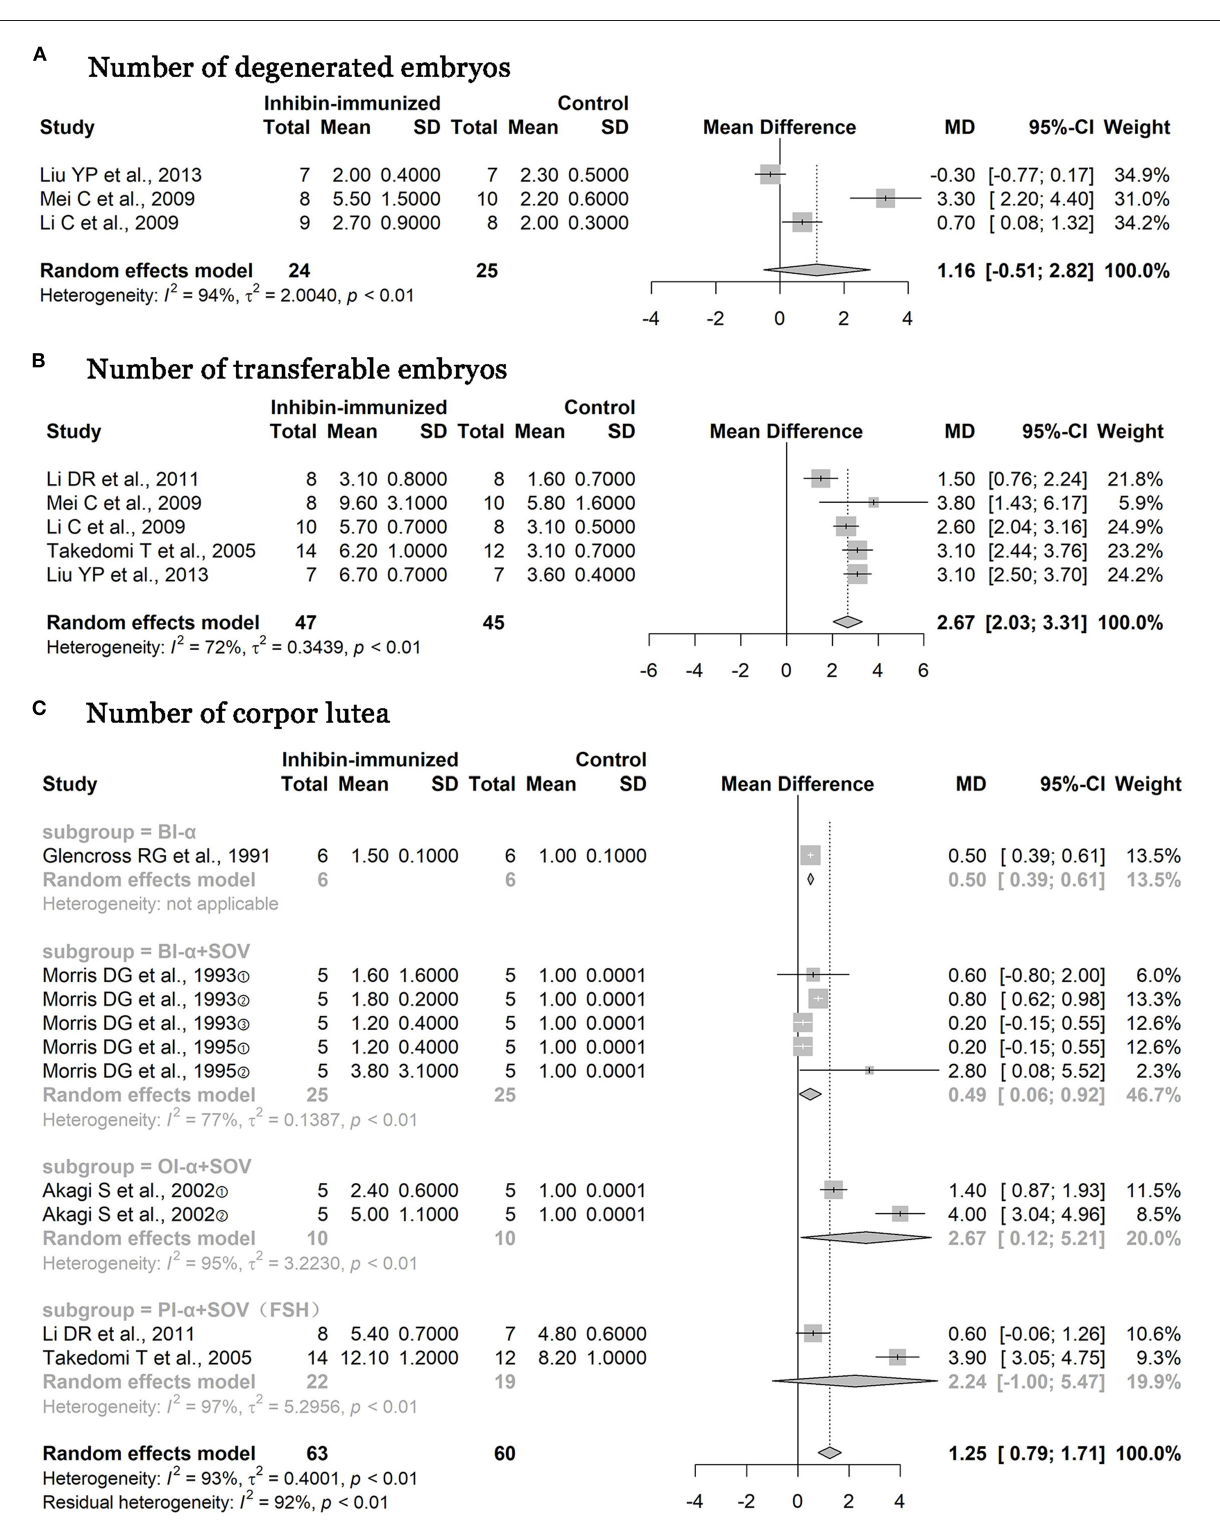
Frontiers in Veterinary Science |